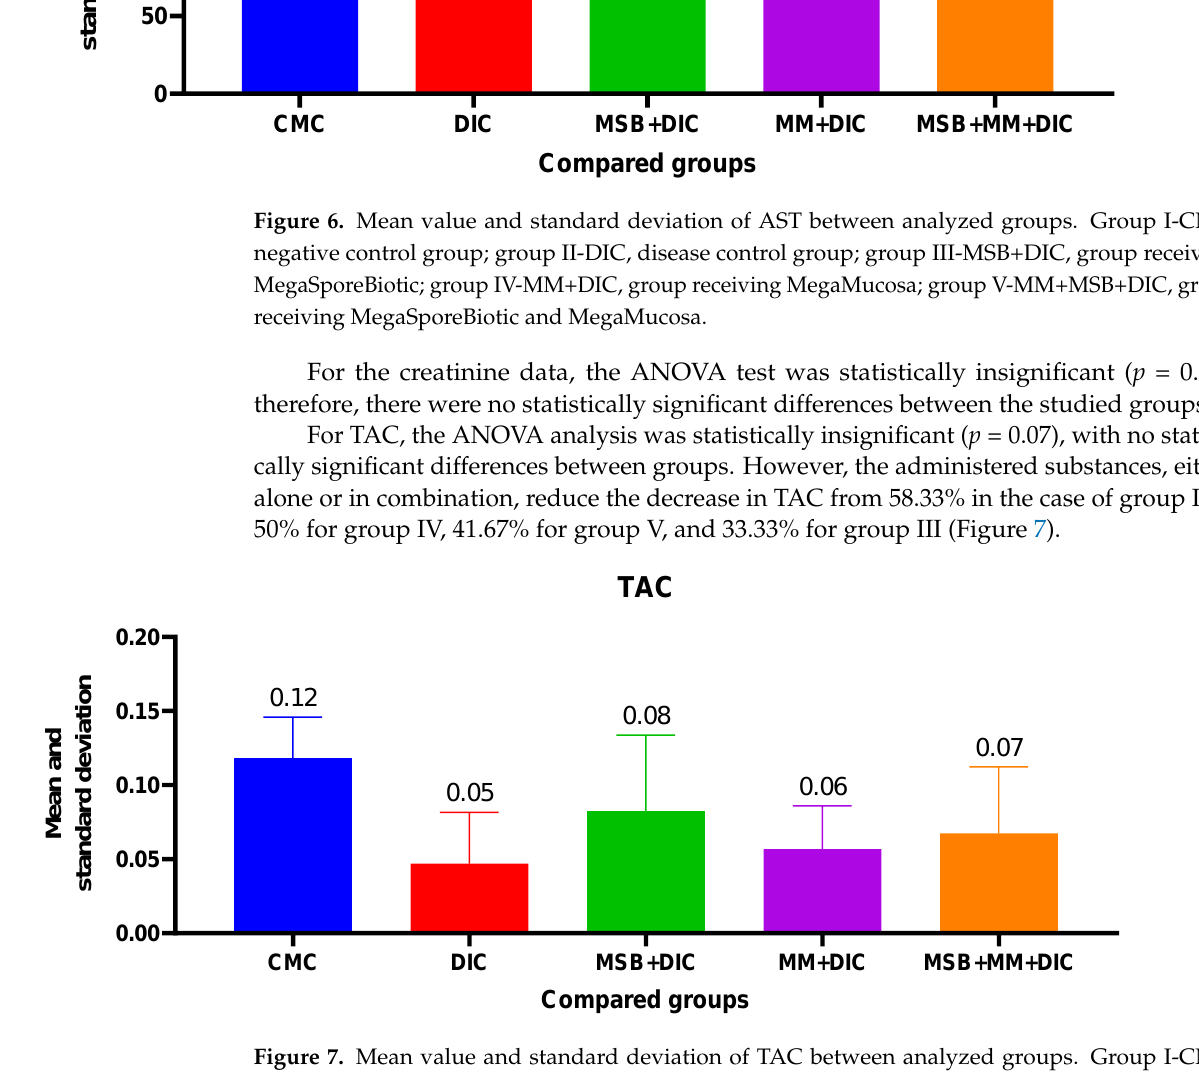
Figure 8. Mean value and standard deviation of CAT between analyzed groups. Group I-CMC, neg- ative control group; group II-DIC, disease control group; group III-MSB+DIC, group receiving Meg- aSporeBiotic; group IV-MM+DIC, group receiving MegaMucosa; group V-MM+MSB+DIC, group receiving MegaSporeBiotic and MegaMucosa.